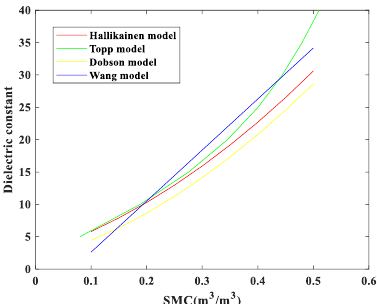
Figure 2 . The four soil models on American silty loam soil （ C=0.13 ， S=0.25 ）